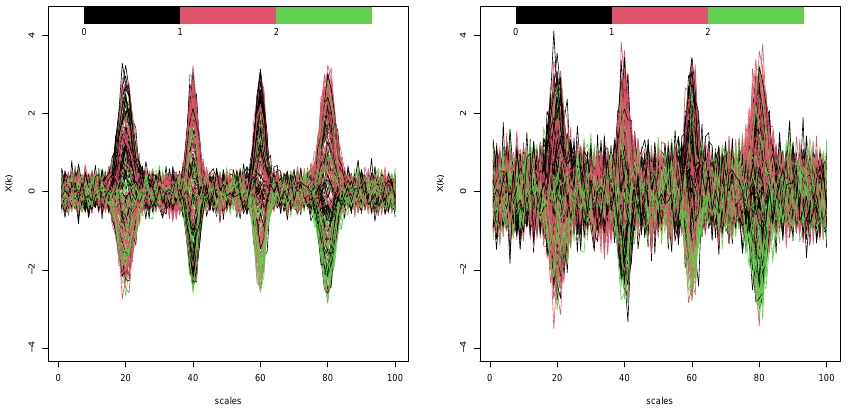
Figure 1. Functional predictors X i ( k ) , i = 1, . . . , n , colored by the corresponding outcome variable ( C 1 in black, C 2 in red and C 3 in green) for two different values of the standard deviation in the error term ( σ 0 = 0.05 in the left, and σ 0 = 0.25 in the